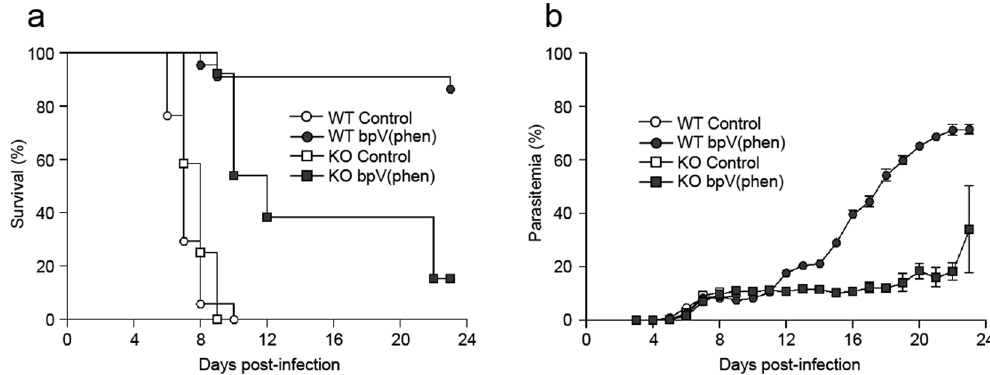
Figure 3. PTP inhibition partially protects IL-10KO mice from P. berghei ANKA infection. ( a ) Survival and ( b ) parasitemia of bpV(phen)-treated WT and IL-10KO mice infected with P. berghei ANKA. The cumulative average of 4 independent experiments is shown. n = 17 for control, WT mice, n = 22 for bpV(phen)-treated, WT mice, n = 12 for control, IL-10KO mice and n = 13 for bpV(phen)-treated, IL-10KO mice. For bpV(phen)- treated, WT mice versus bpV(phen)-treated IL-10KO mice, P < 0.0001, and for control, IL-10KO mice versus bpV(phen)-treated IL-10KO mice, P < 0.0001, using the log-rank test.